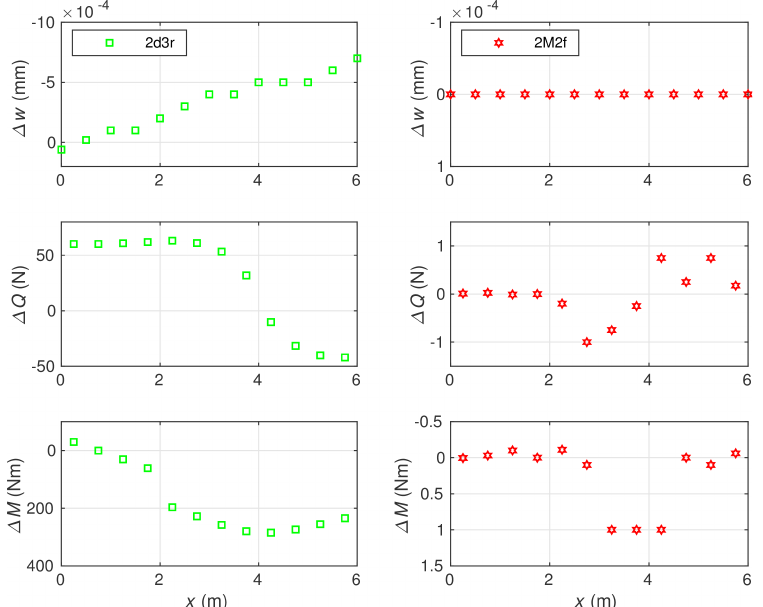
Figure 12. Comparison of errors for the deflections, shear forces and bending moments obtained with 12 element meshes: for 2d3r ( left diagrams ) and 2M2f ( right diagrams ). K s = 1.0714 · 10 9 N.